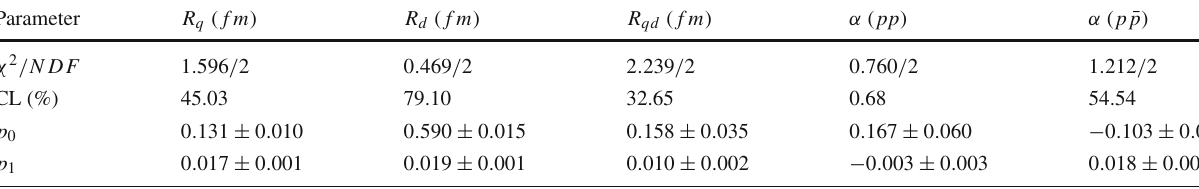
Table 2 Summary of the parameter values which determine the energy dependence by fitting a linear logarithmic model according to Eq. (10). The values of the parameters are rounded up to three valuable decimal